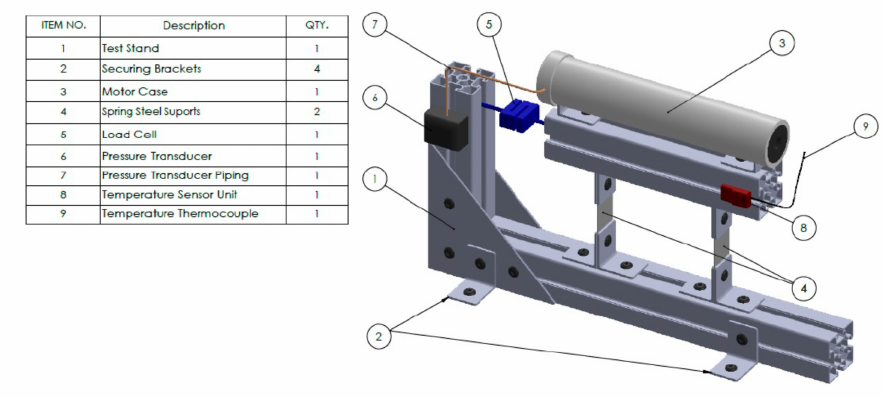
Figure 1. Schematic of the laboratory-rocket motor test stand with